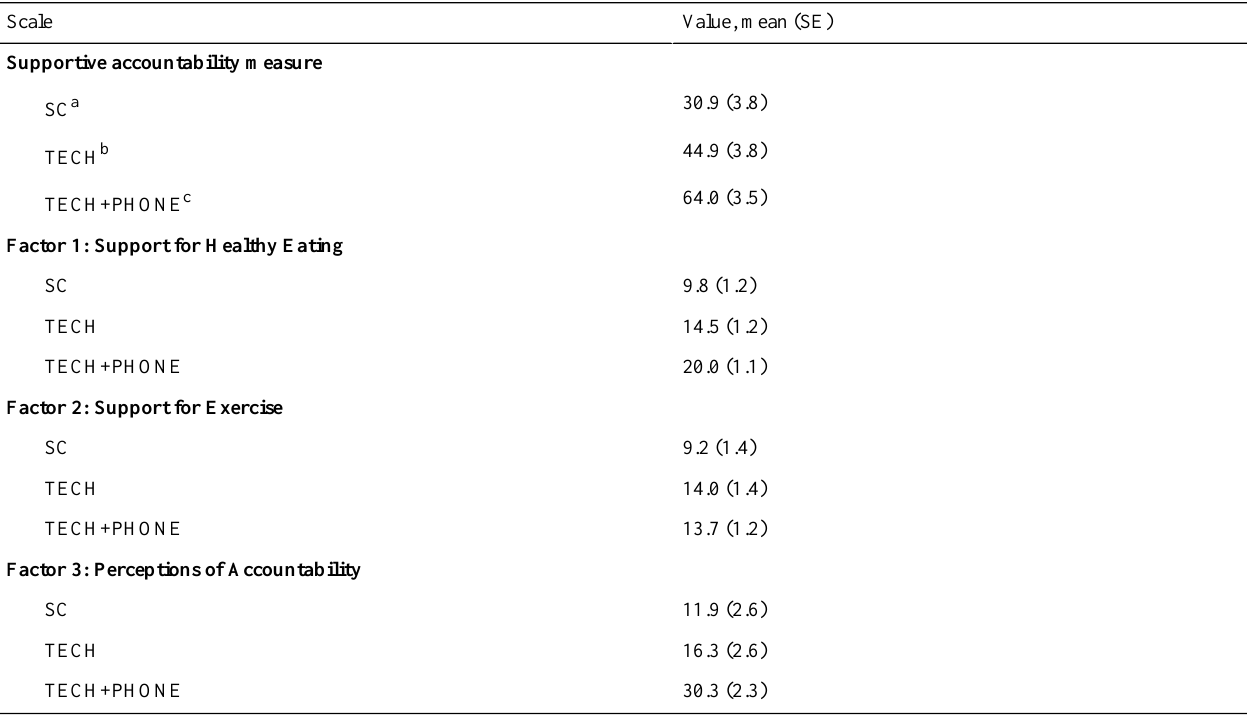
Table 4. Six-month scores on supportive accountability measure (SAM) and each of the three SAM subscales by intervention group.